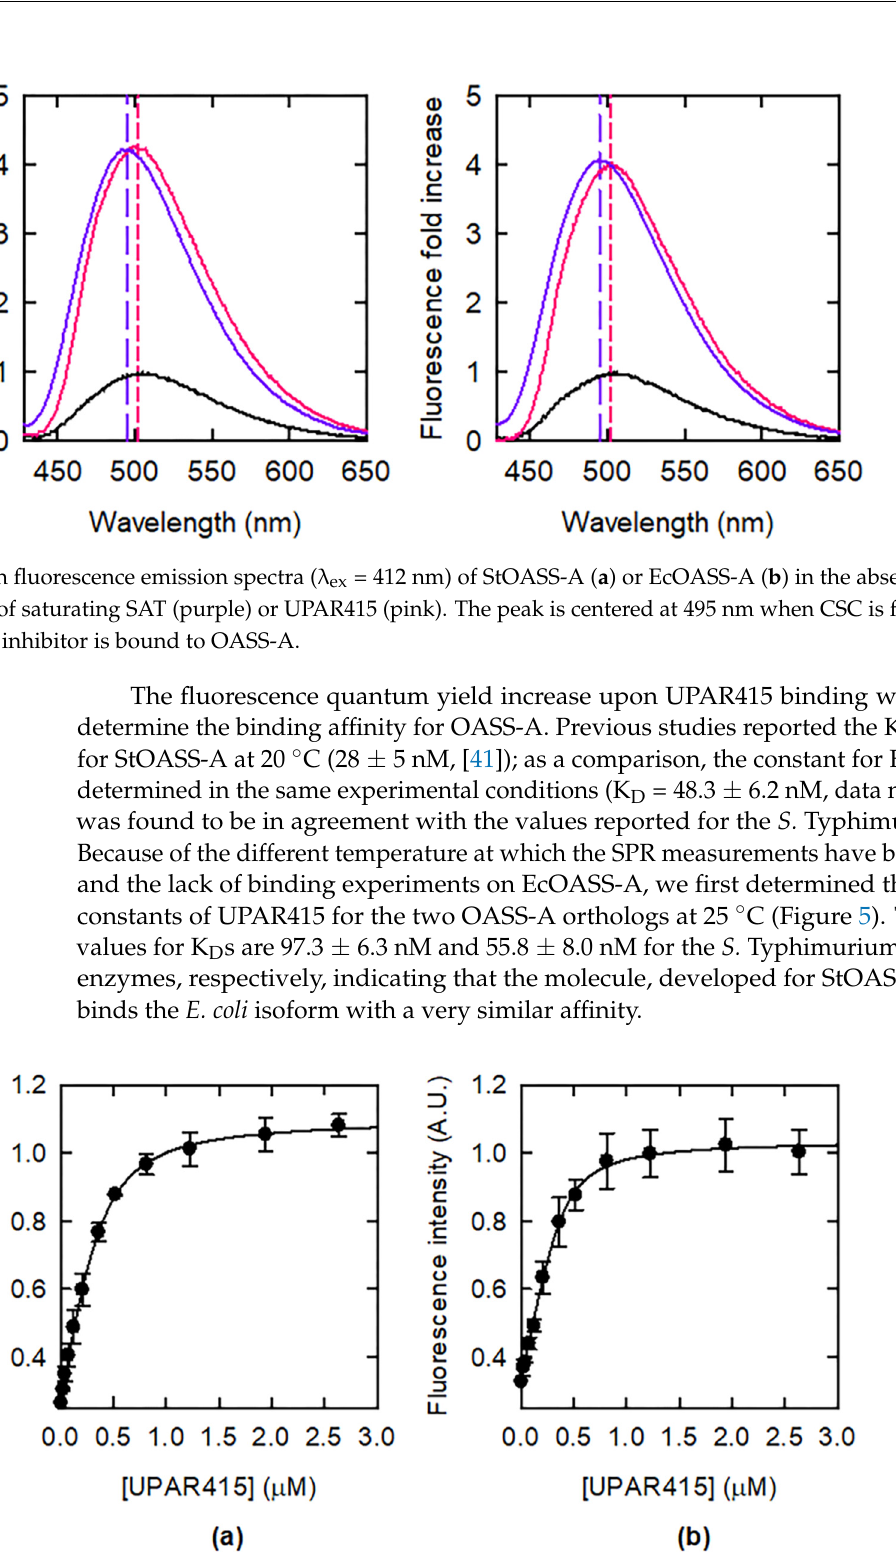
Figure 5. Binding of UPAR415 to StOASS-A ( a ) and EcOASS-A ( b ) at 25 °C. Fluorescence emission intensities at 500 nm upon excitation at 412 nm were fitted to a tight-binding equation (Equation (5)) giving K D values of 97.3 ± 6.3 nM for StOASS-A and 55.8 ± 8.0 nM for EcOASS-A.